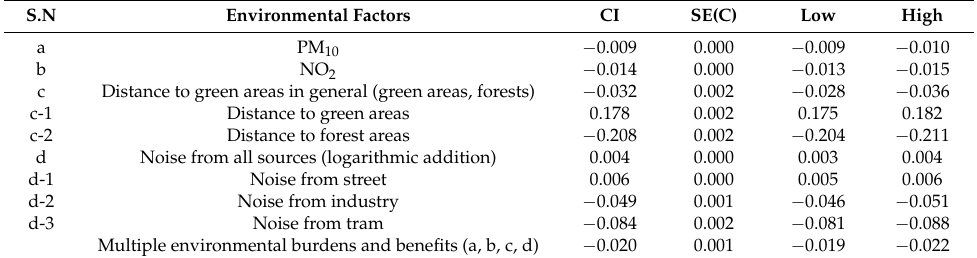
Table 9. Concentration indices (CI), standard errors (SE) and 95% confidence intervals for individual environmental factors and multiple environmental burdens and benefits with respect to social vulnerability. S.N Environmental